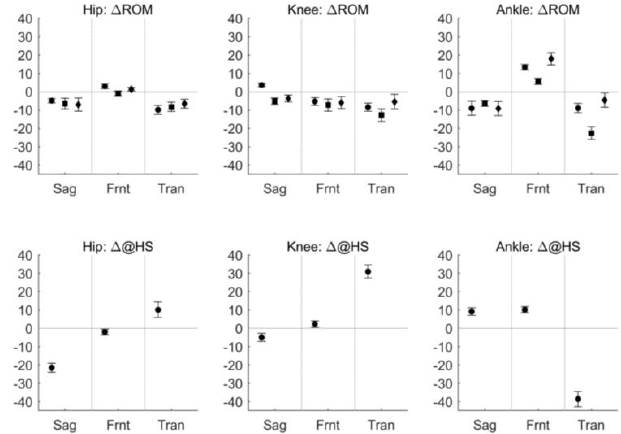
Figure 8. Difference between MVN BIOMECH and VICON data at discrete, clinically relevant events. The difference in minimum angle (Δmin; top row ), maximum angle (Δmax; second row ), range of motion (ΔROM; third row ) and angle at heel strike (Δ@HS; bottom row ) between the MVN BIOMECH and VICON systems for the hip ( left ), knee ( centre ) and ankle ( right ) joints in the sagittal (Sag), frontal (Frnt) and transverse (Tran) planes of movement. The three data points in each plane correspond to the walk (left-most point; circle), squat (centre point; square) and jump (right-most point; diamond) tasks. Positive values indicate that MVN BIOMECH angle was larger than VICON angle. Error bars indicate 95% confidence interval of the difference.